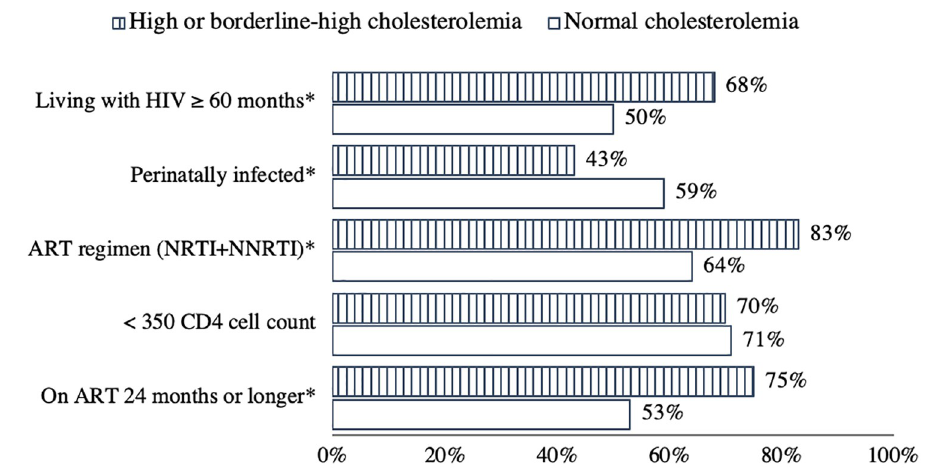
Fig 1. Distribution of cholesterolemia status by HIV-specific factors. � P < 0.05 (Chi-square test of association) Source: Data from the 2016 UHS (n = 486) and 2019/2020 (n = 370) STEP surveys,